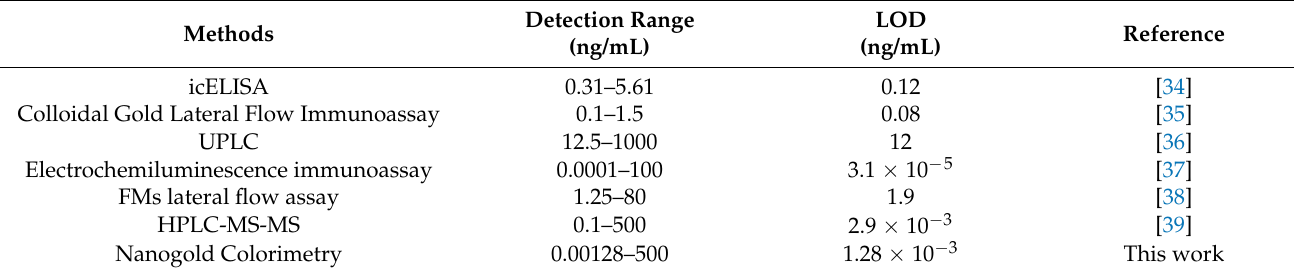
Table 1. Comparison of this method with other detection